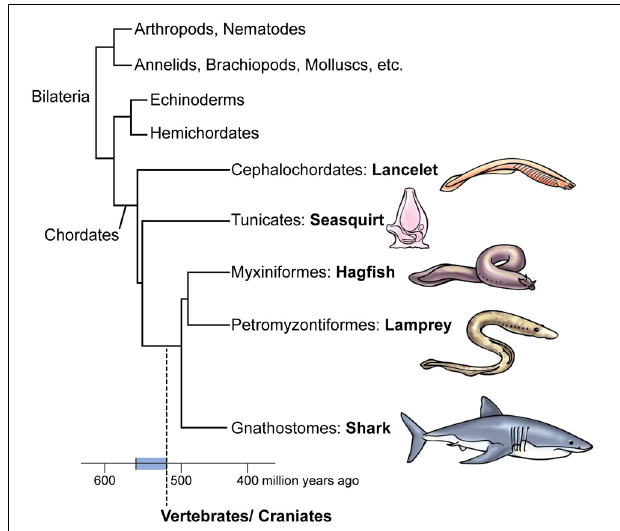
FIGURE 1 | Tree and timeline of the evolution of vertebrates. Note the subgroups of the chordates. The vertebrate/craniate lineage evolved during the Cambrian Period approximately 560–520 million years ago (blue bar on the timeline). The two basic subdivisions of vertebrates are the jawless cyclostomes, namely hagfish and lamprey, and the jawed gnathostomes, to which we humans belong. The lamprey is thought to retain more features of the ancestral first vertebrate than do hagfish or